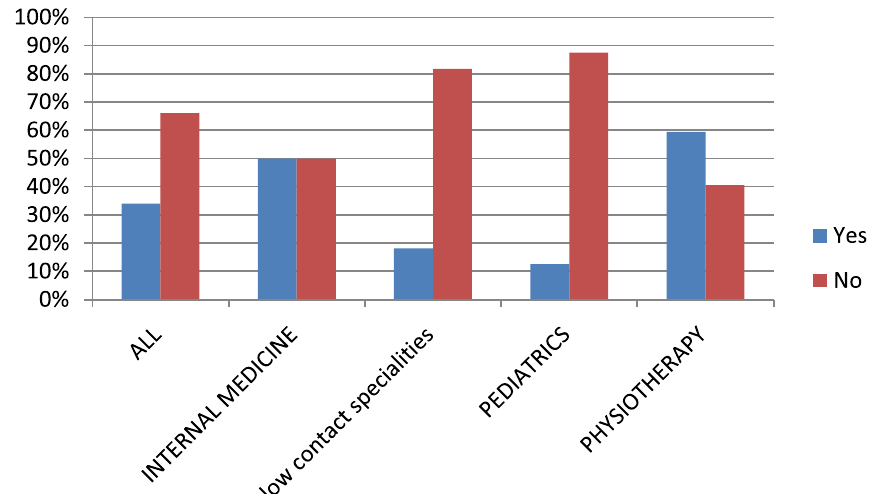
Fig. 2 Percentages of receiving academic and/or professional training in dysphagia in different